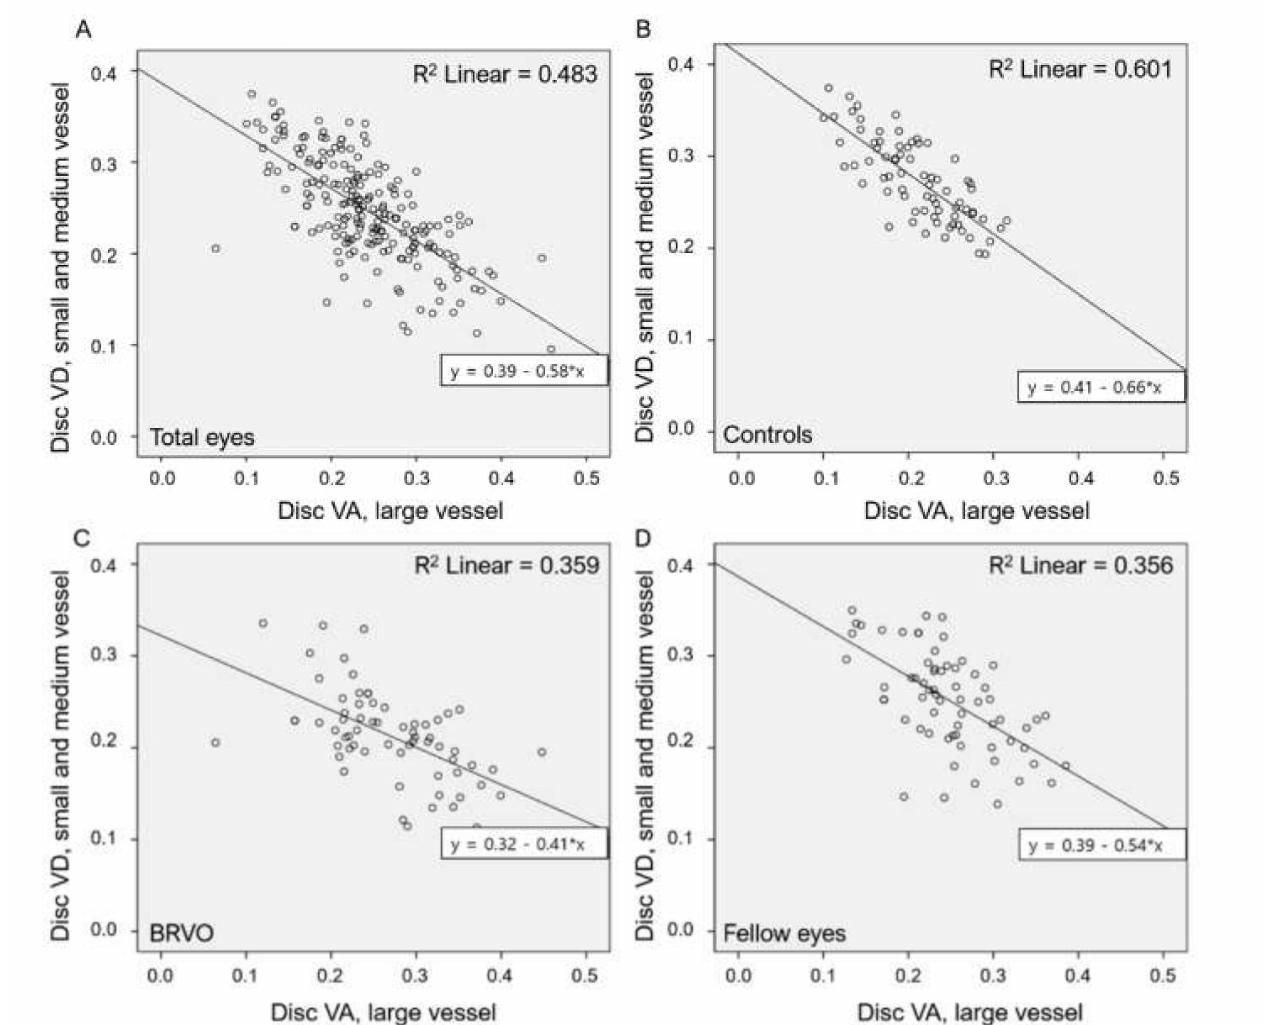
Figure 3. Correlations between large and small and medium vessel VDs in the optic disc area: ( A ) Large vessel VD correlated negatively with small and medium vessel VD; ( B – D ) This correlation remained consistent when patients were divided into groups.